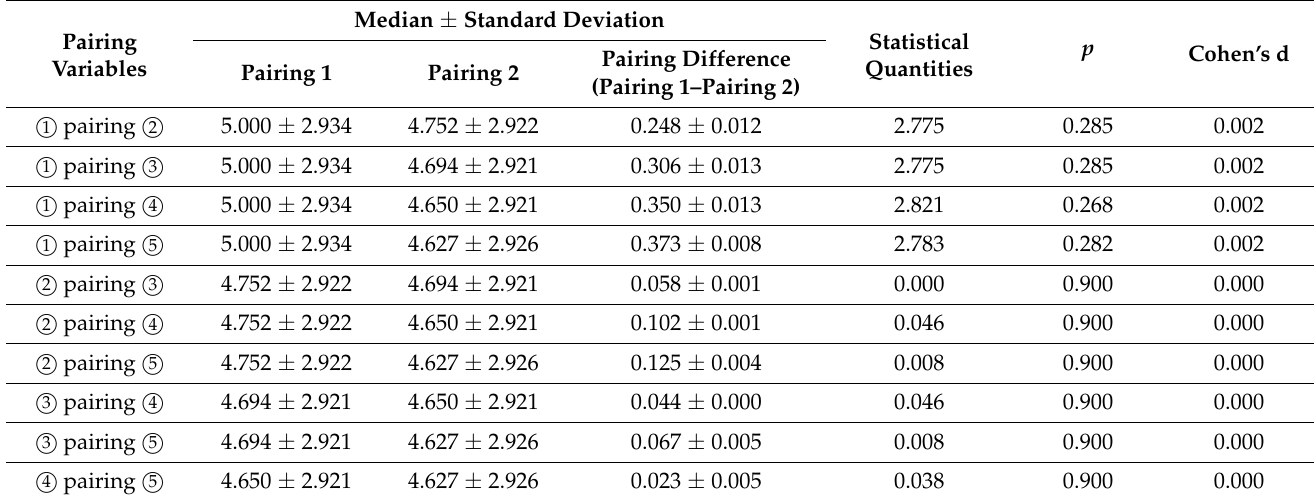
Table 6. The post hoc Nemenyi test using CEEMDAN-LSTM for multiple